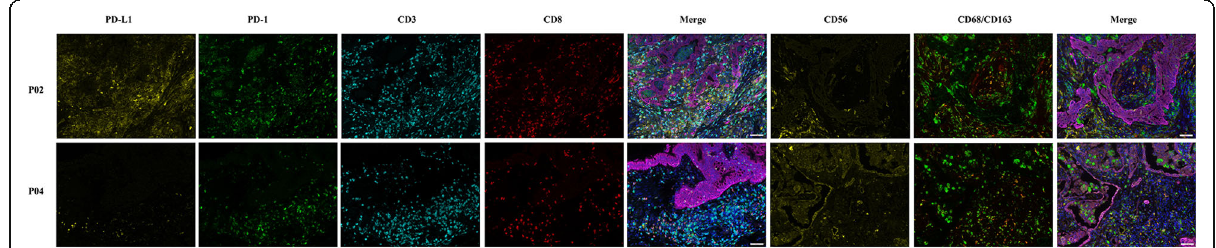
Fig. 6 Multiplex immunofluorescence staining for PD-1, PD-L1, CD3, CD8, CD68, CD56 and CD163 in the tumor tissue of the patients with